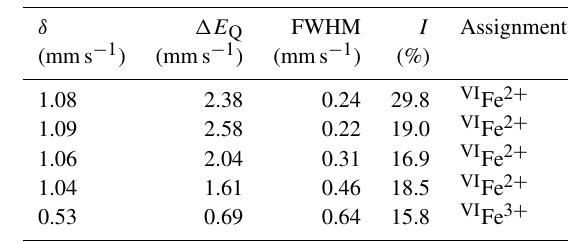
Table 3. Mössbauer parameters for tourmaline (dutrowite and asso- ciated oxy-dravite) collected at room temperature.